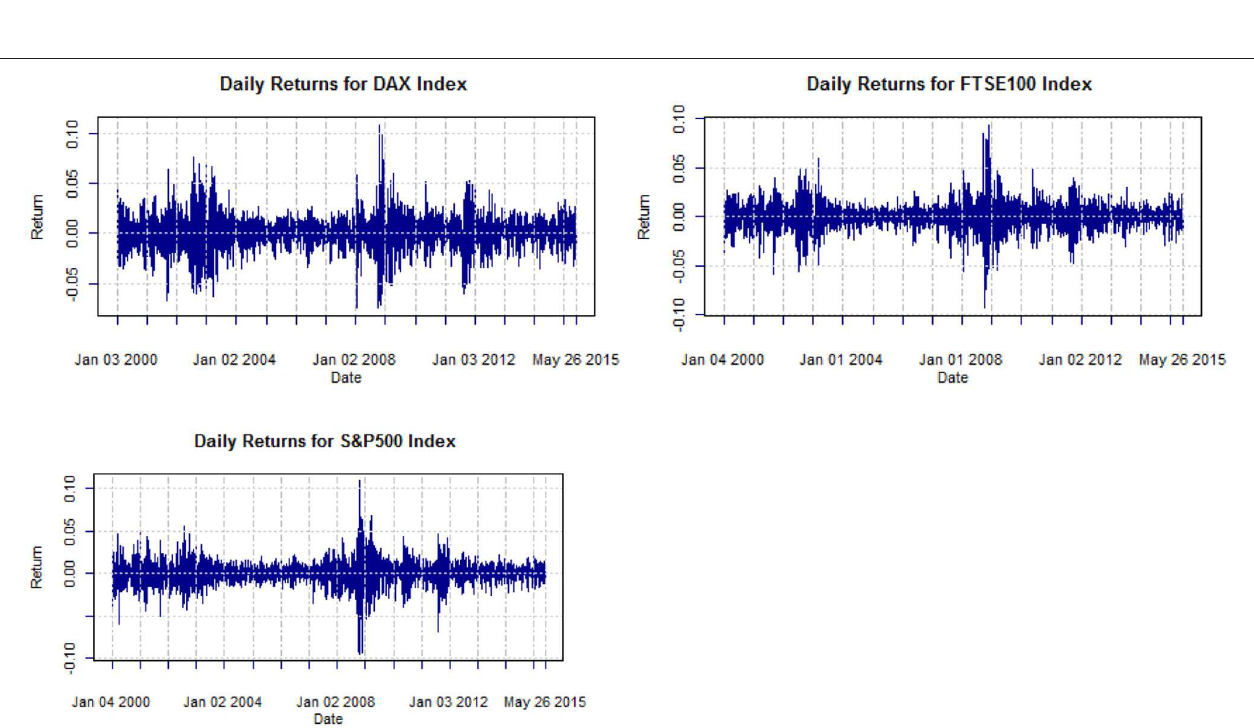
FIGURE 2 | Daily returns of adjusted closing prices of DAX, FTSE100, S&P500, from Jan. 2000 to May 2015.